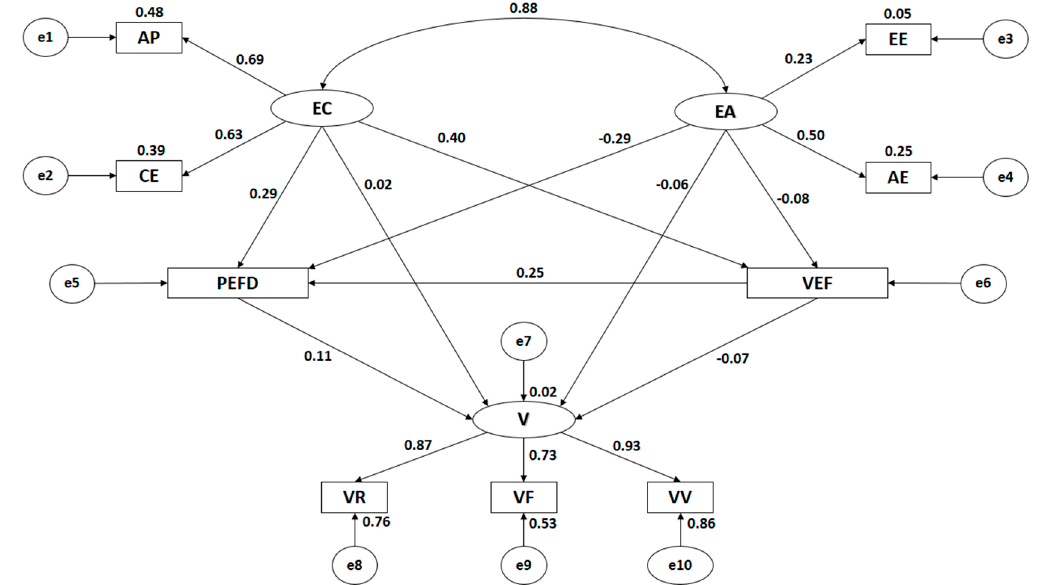
Figure 3. Structural equation model for sedentary participants.